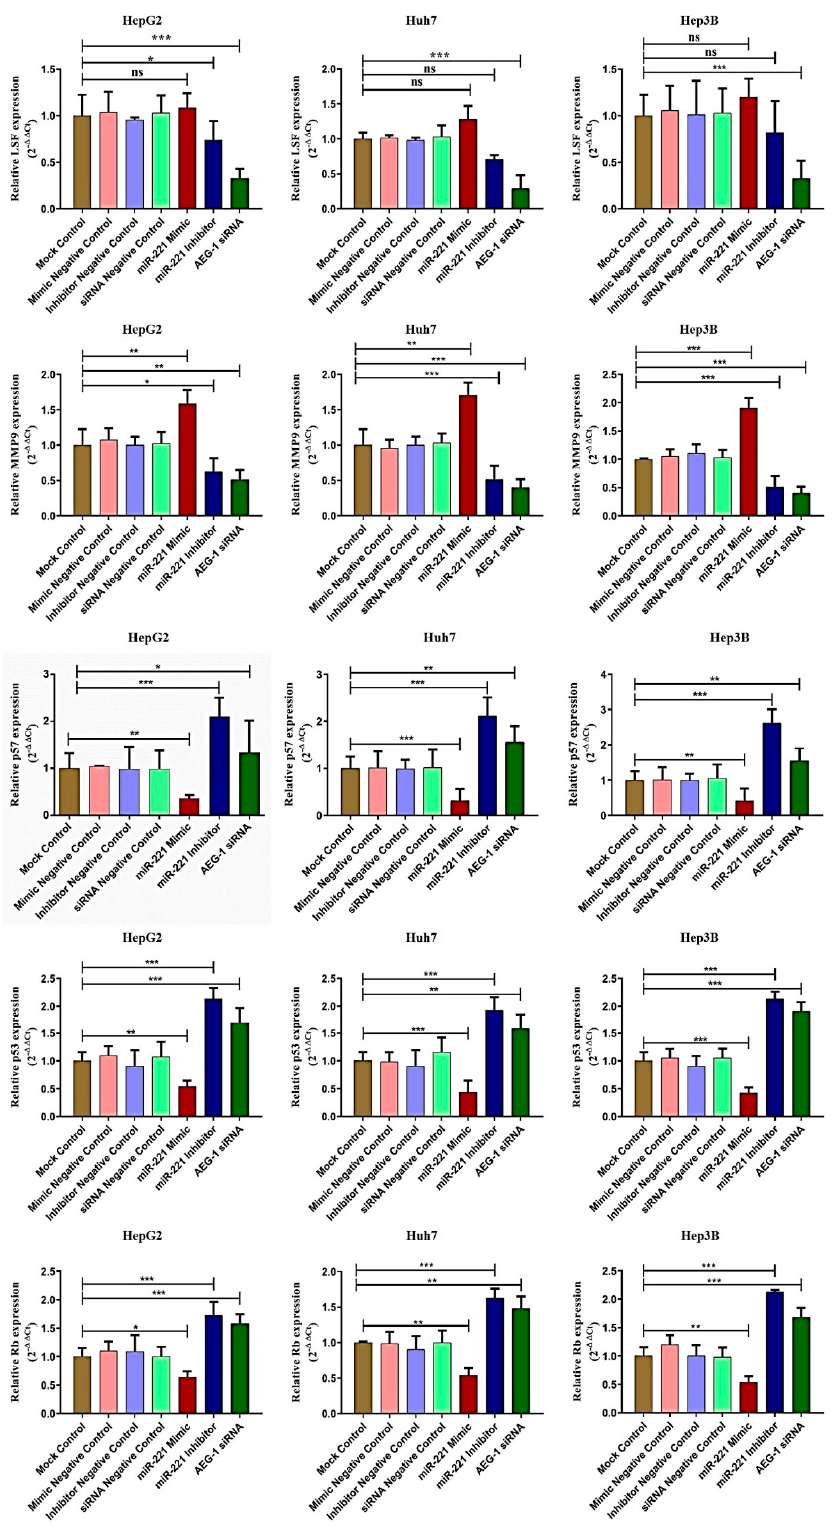
Figure 3. AEG-1 and miR-221 regulate angiogenesis and cell cycle regulatory mRNA expressions in the HCC cell lines. The regulatory mRNAs expressions which regulate angiogenesis (LSF and MMP9) and cell cycle (p57, p53, and RB) were analyzed in miR-221 mimic-, miR-221 inhibitor-, AEG-1 siRNA-, and their corresponding control-transfected HepG2, Huh7, and Hep3B cells by using qRT- PCR. The GAPDH was used as an internal control. Error bars presented as mean ± s.d and p -values represented as * p < 0.05, ** p < 0.01, and *** p < 0.001. ns represented as